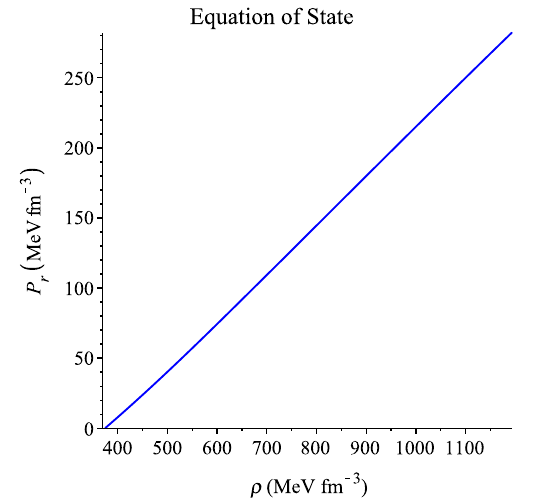
Fig. 4 Plotofradialandtangentialpressuregradientsfortheparameter values used in Fig. 1. The solid (blue) line corresponds to κ d P r / d r (Eq. (7.2.6)), and the dashed (red) line corresponds to κ d P t / d r (Eq. (7.2.8))